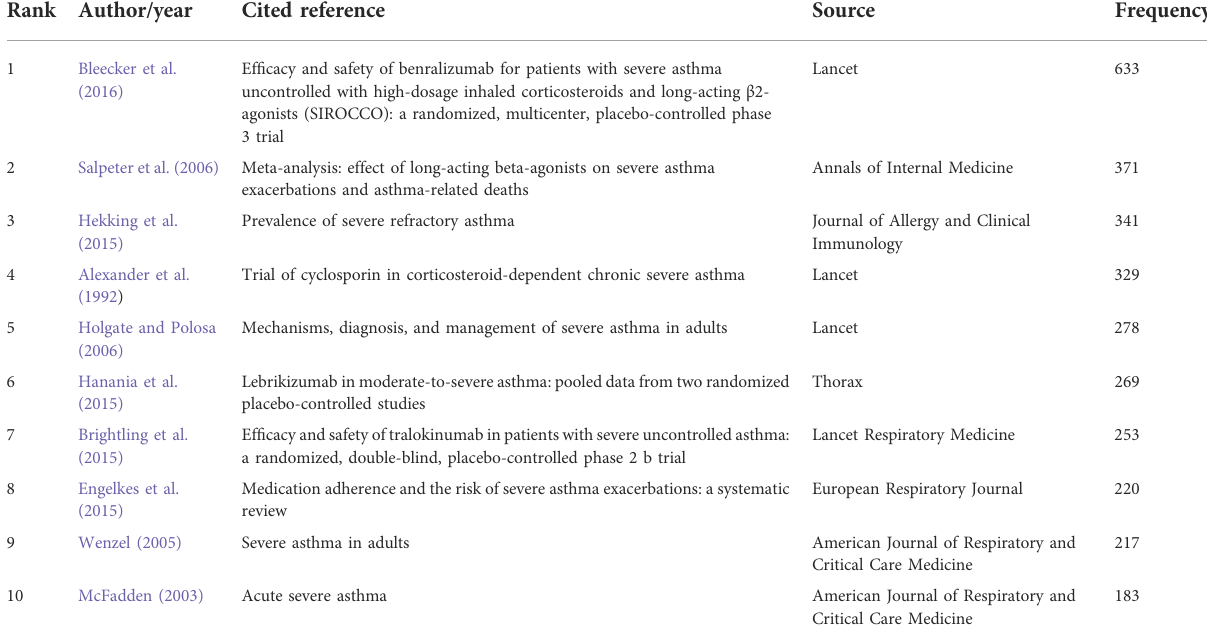
TABLE 9 Top 10 cited references in severe asthma drug-related